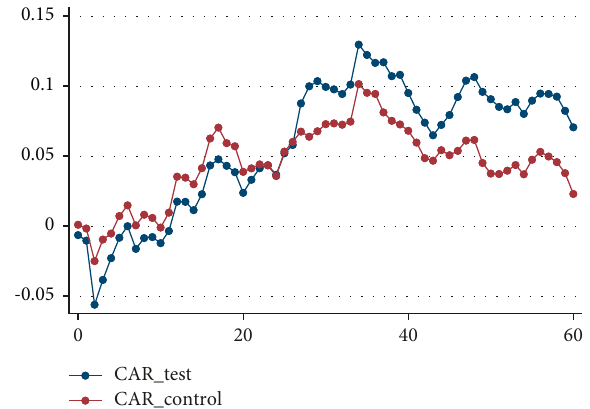
Figure 3: Cumulative abnormal returns of the test group and the control group. Note. This figure gives the cumulative abnormal returns for the test group and the control group in the subsequent 60 trading days. The red line and blue line represent the cumulative abnormal returns of the test group and the control group,